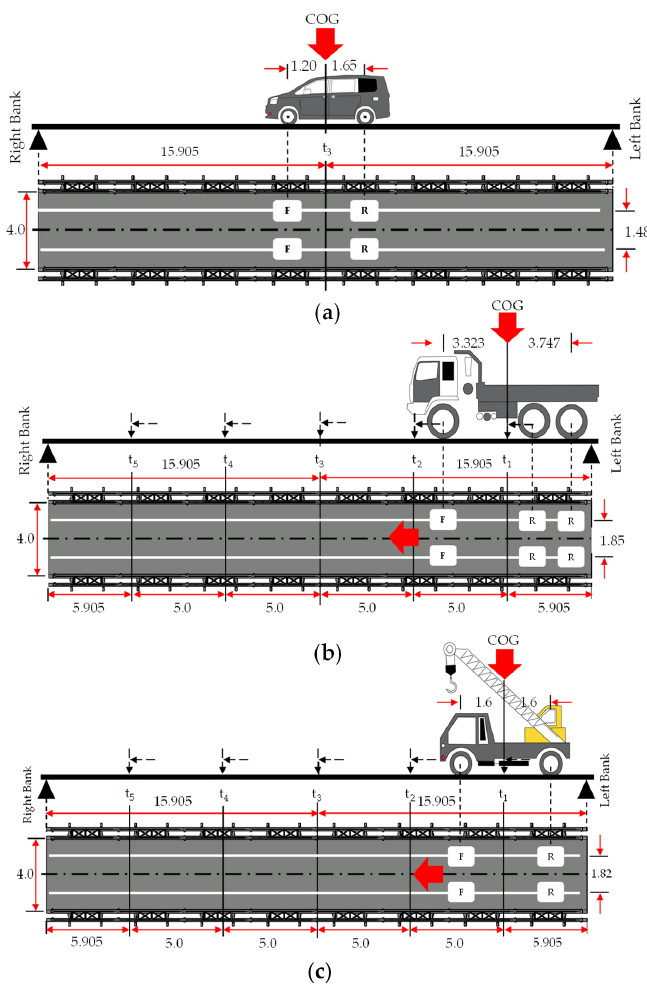
Figure 3. Static loading conditions (unit: m): ( a ) Loading case 1; the target set at midspan (t 3 ) for measurement of displacement; Metadata: Car, wheel spacing of 1.48 m and axle spacing of 2.85 m.